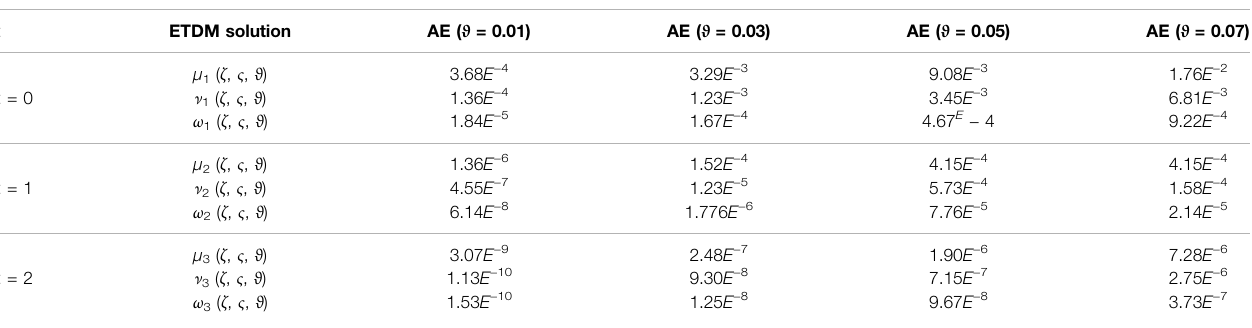
TABLE 3 | AE of ETDM at different time levels and